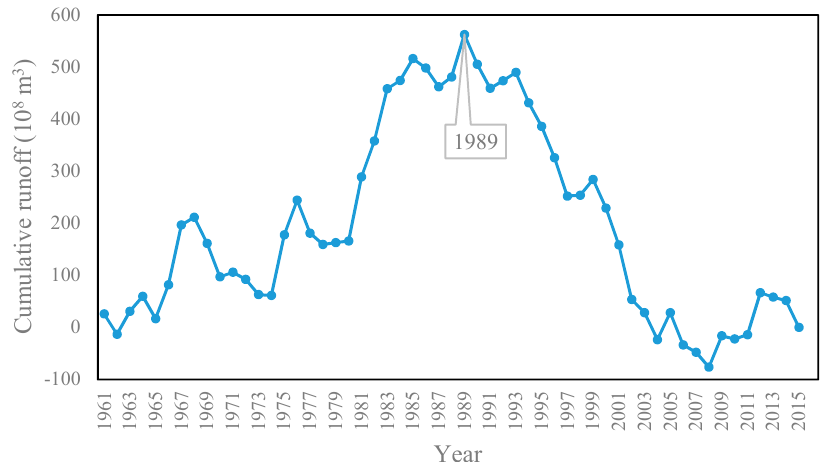
Figure 5. Result of the accumulative runoff anomaly of the source area of the Yellow River from 1961 to 2015.